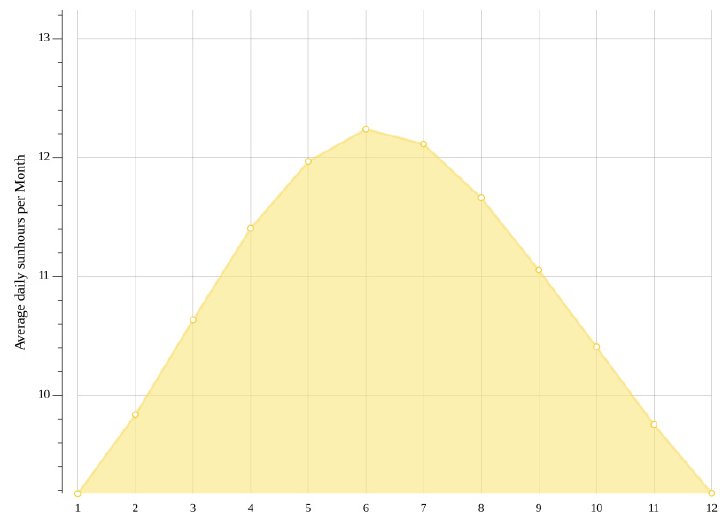
Figure 8. Average daily sun hours per month in Al Ain. Table 1 . Average 10 years data for temperature, humidity, and precipitation for the city of Al Ai.